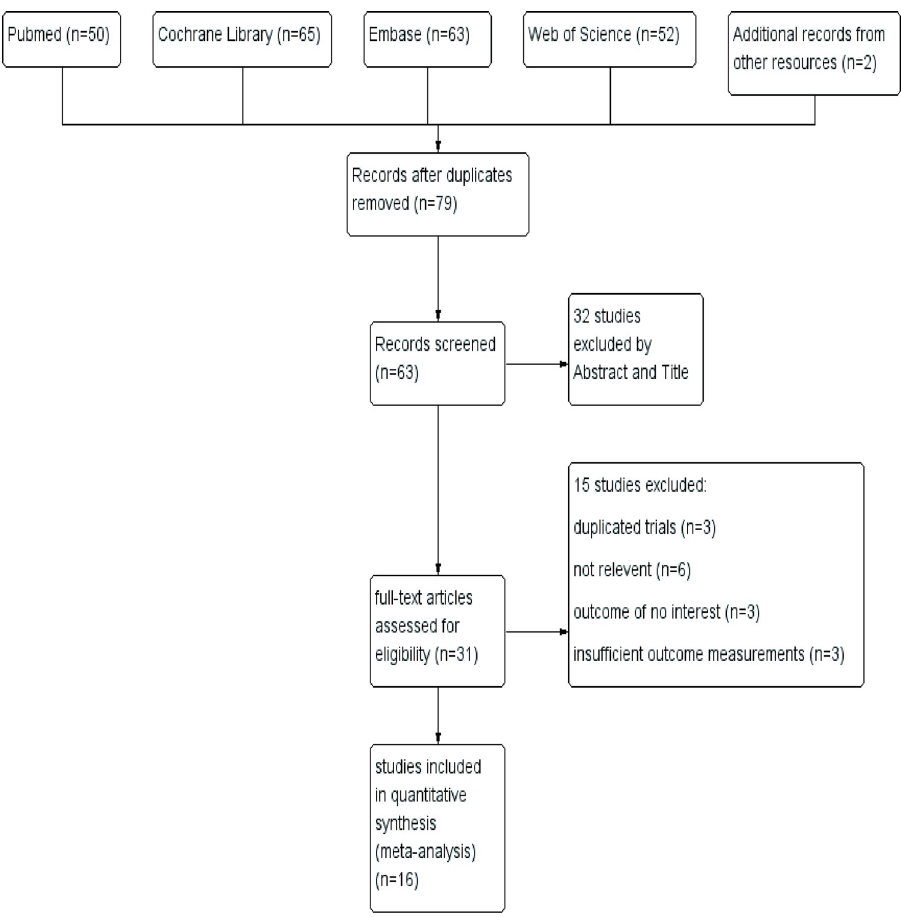
Fig 1. Flow diagram of study inclusion and